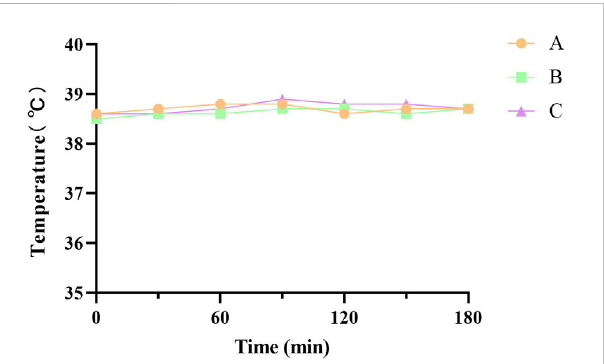
FIGURE 9 Temperature test curve of New Zealand white rabbits. A, B and C are tests on threeNew Zealand White rabbits(Test every 30 min Sixtests in total.).